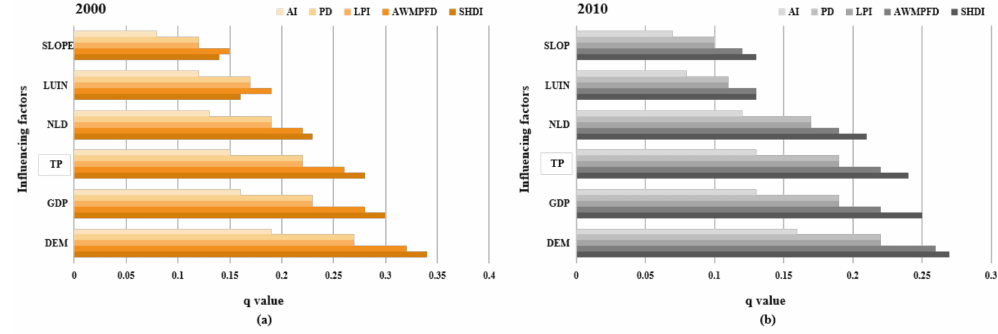
Figure 9. The force q among each influencing factor on each landscape pattern metric in ( a ) 2000 and ( b ) 2010.